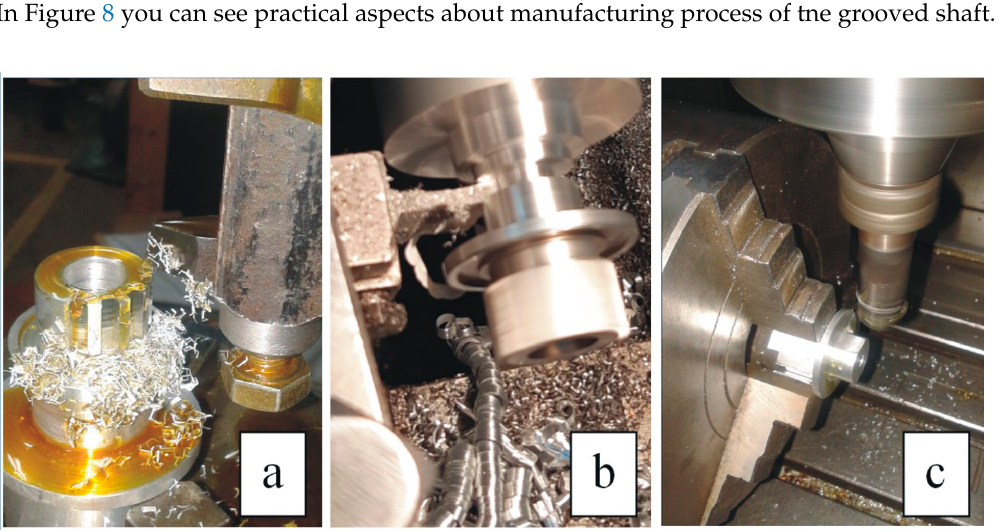
Figure 8. Slotting the groove ( a ), cutting the piece ( b ) and milling the square profile ( c ).